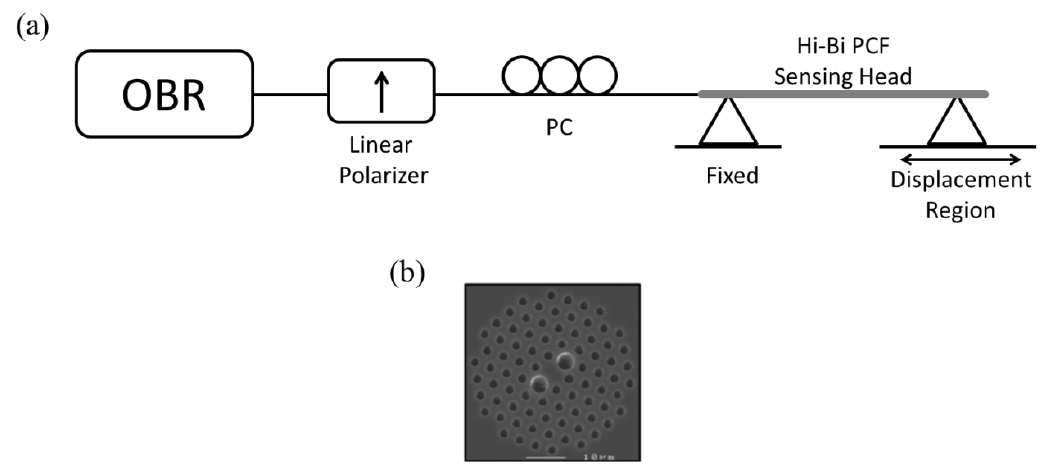
Figure 1. ( a ) Schematic of the experimental setup used to characterize the Hi-Bi PCF sensing head and ( b ) optical microscopic picture of the Hi-Bi PCF cross-section.